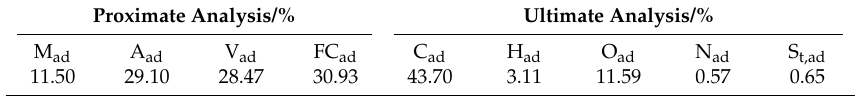
Table 1. Proximate and ultimate analysis of the test coal (%).